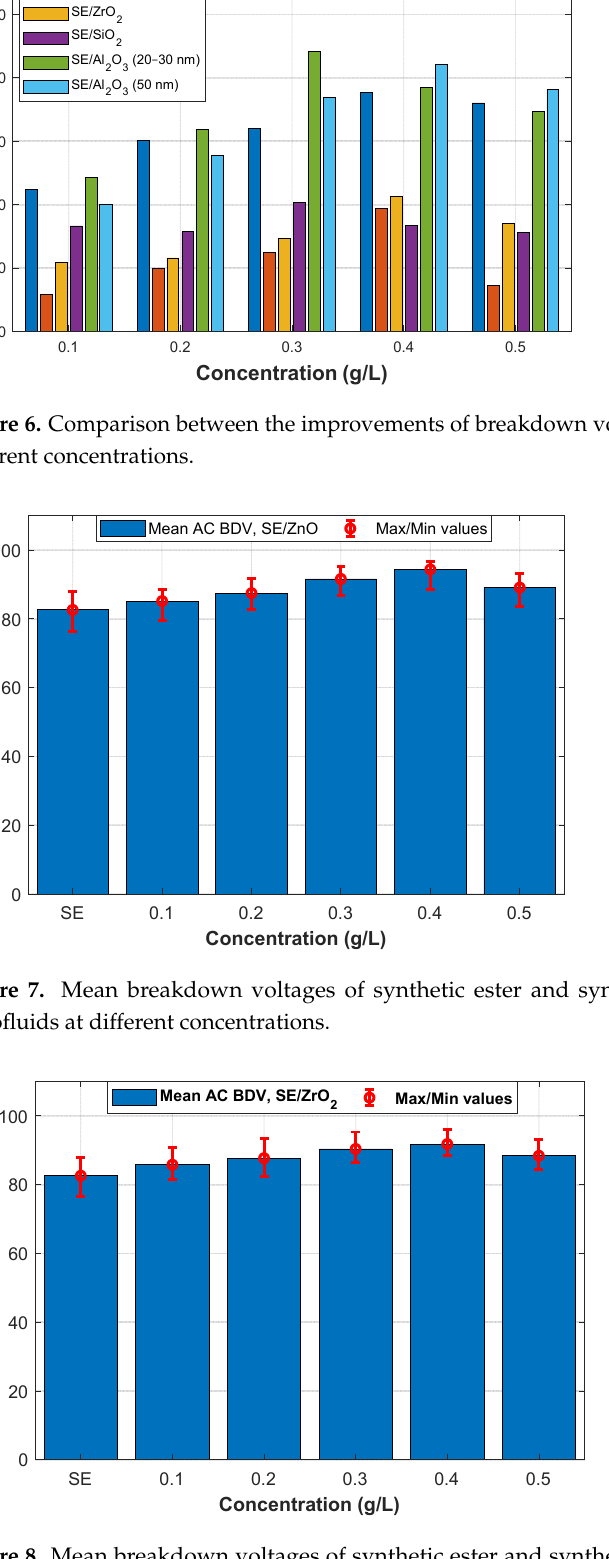
Figure 8. Mean breakdown voltages of synthetic ester and synthetic ester-based ZrO 2 (20–30 nm) nanofluids at different concentrations.